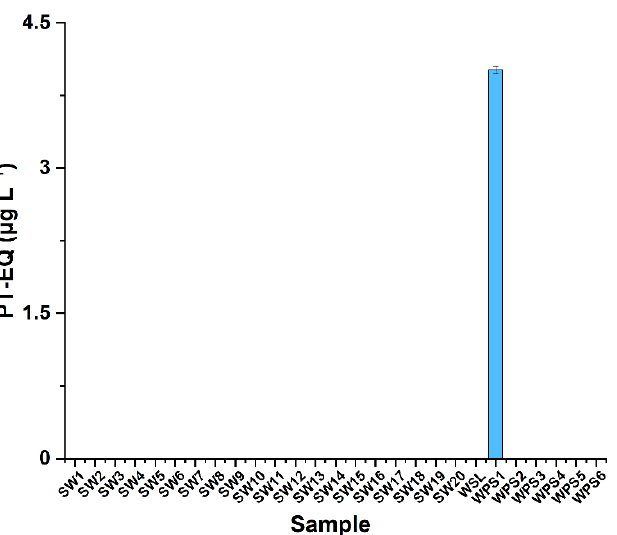
Figure 4. PT-EQ ( μ g L − 1 ) mean values of the samples determined using the AChE inhibition assay. SW1–SW20 show the surface water samples; among these, SW16–SW19 are adjacent to a goose farm. WSL is the sample collected from a water source reservoir, and WPS1–WPS6 are the samples collected from possible pollution sources.